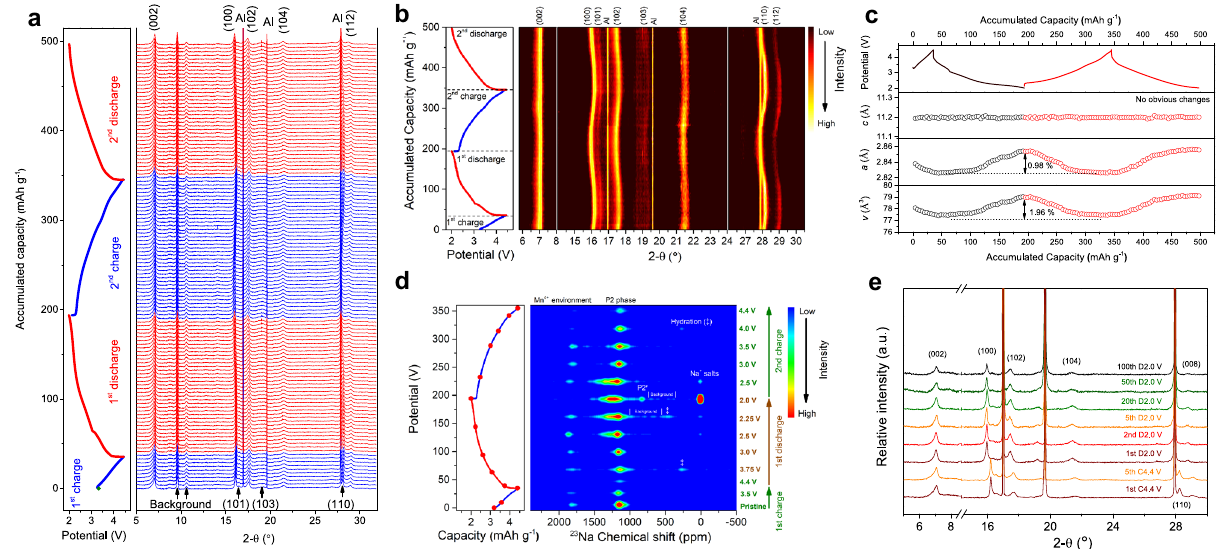
Fig. 6 Structural evolution mechanisms of S-NMO. a In situ XRD patterns, b in situ XRD contour map, c calculated lattice parameters, and d ex situ 23 Na MAS NMR spectra of S-NMO during the charge – discharge processes. e The comparison of XRD patterns of S-NMO at different